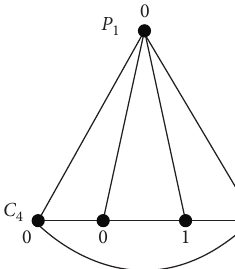
Figure 18: Logical labeling of P